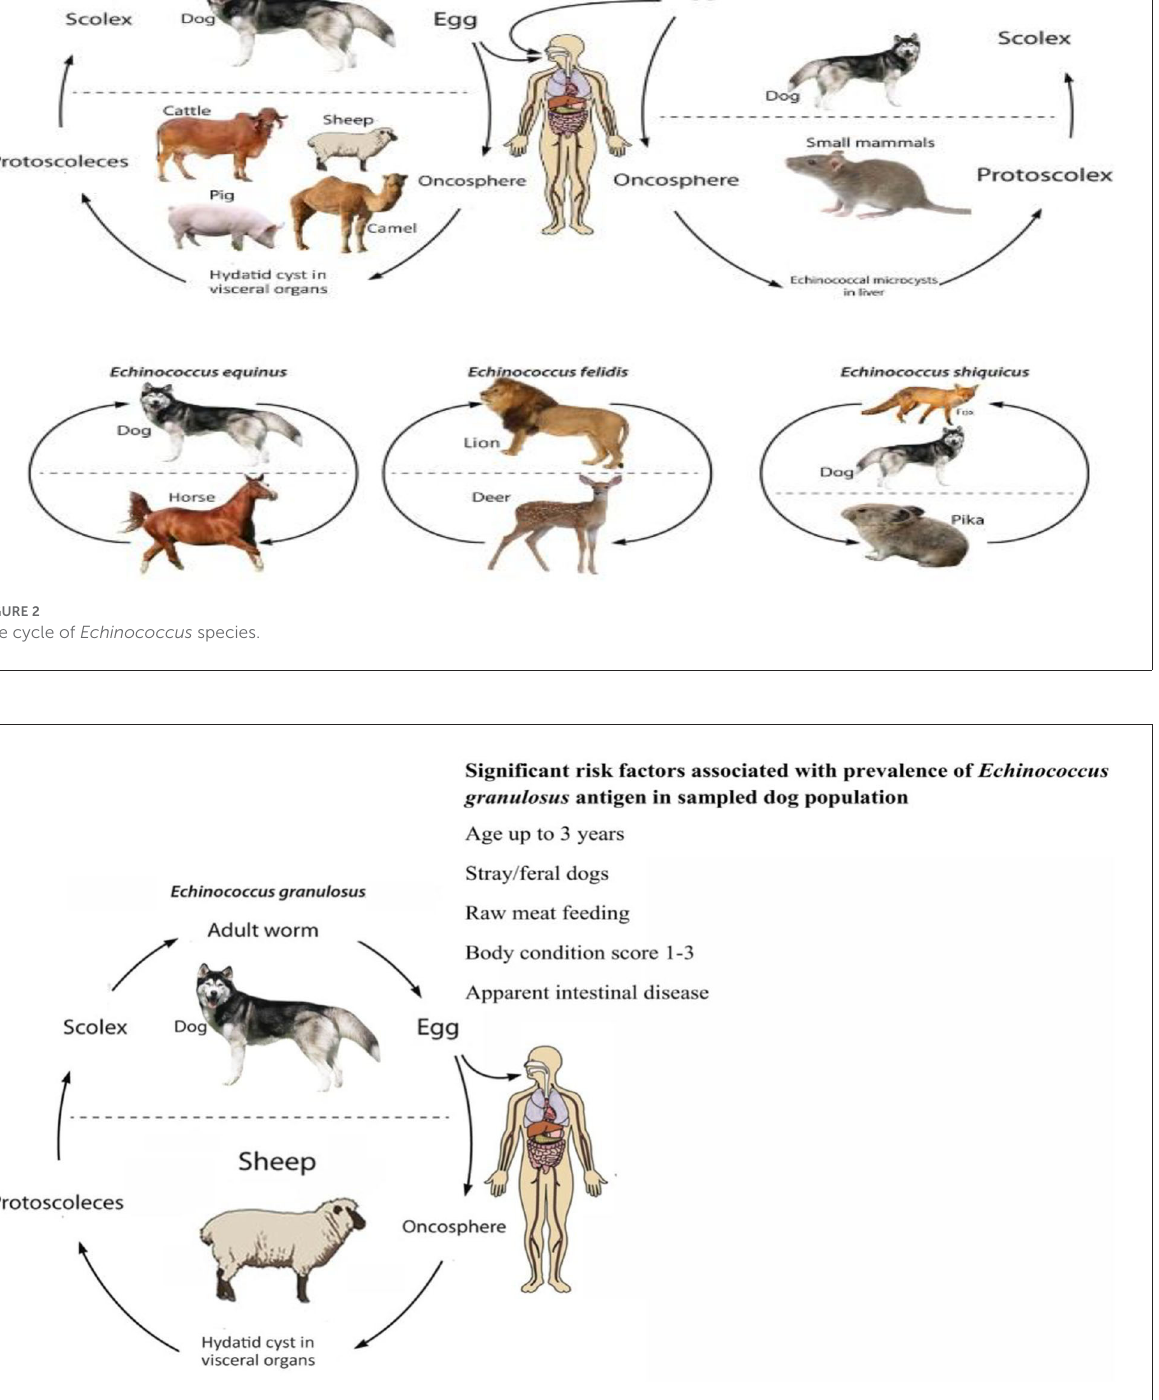
FIGURE3 Risk factors for Echinococcus granulosus in